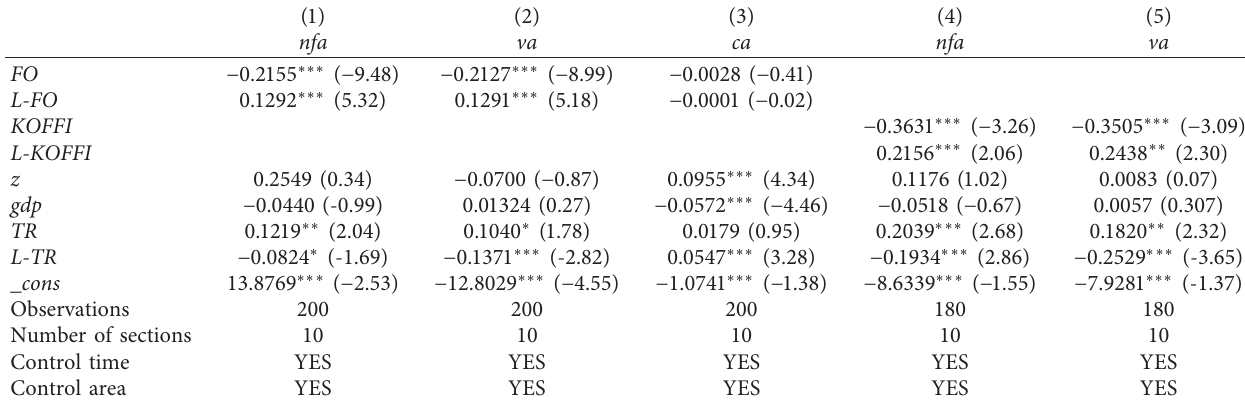
Table 3: Regression estimation results.